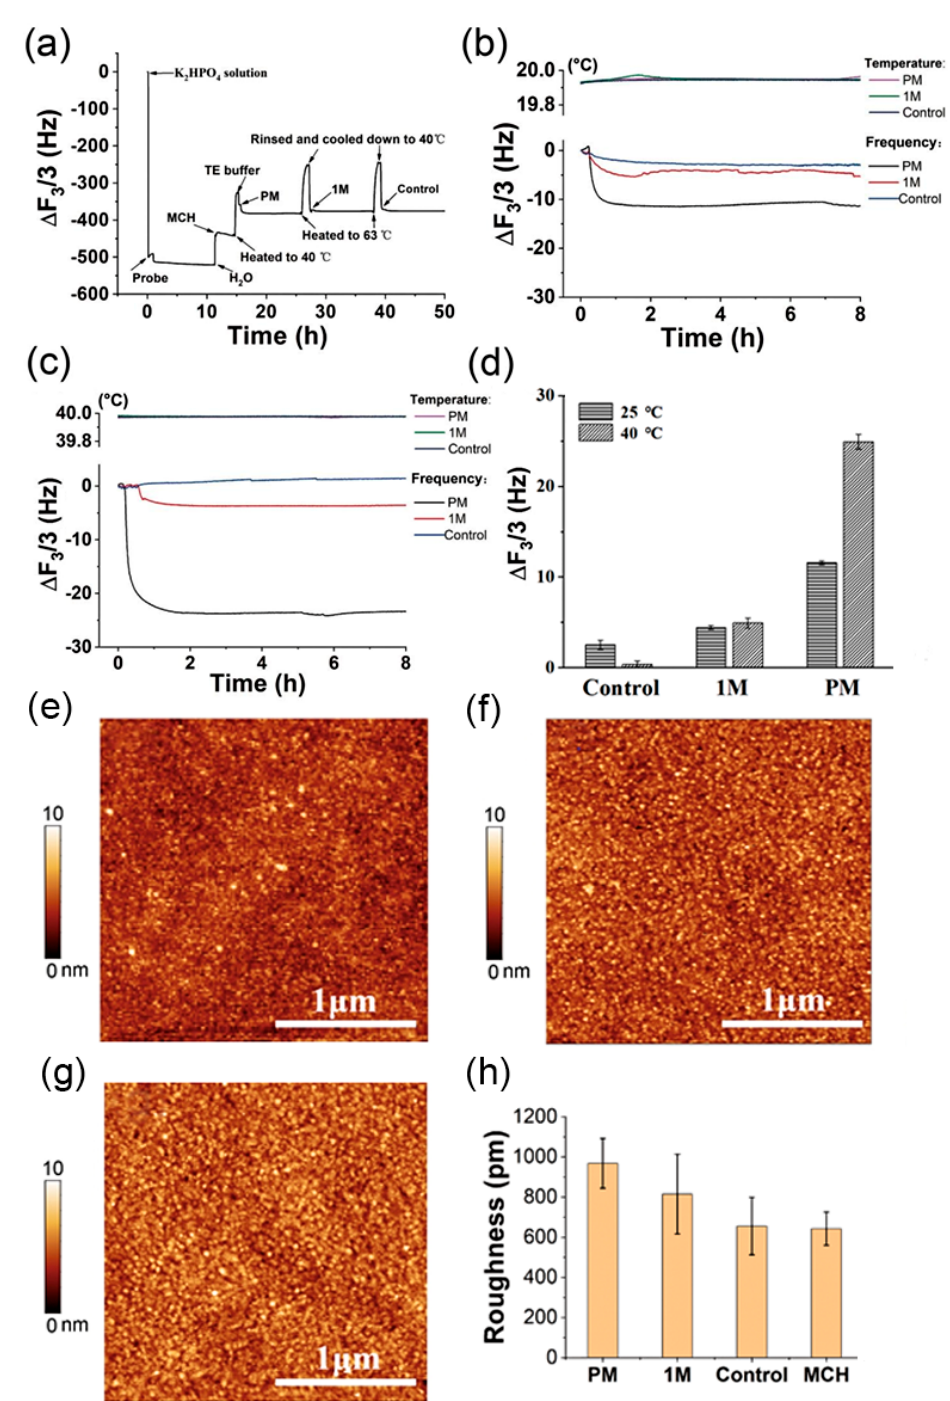
Figure 4. QCM was utilized to measure SNP at different temperatures. ( a ) the frequency of the entire QCM experiment; ( b ) frequency shift for SNP measurement at 20 °C; ( c ) frequency shift for SNP measurement at 40 °C; ( d ) the comparison of QCM frequency shifts at 25 °C and 40 °C; ( e ) AFM image of “Control” sample; ( f ) AFM image of “1 M” sample; ( g ) AFM image of “PM” sample; ( h ) roughness of AFM images of different samples. The scale bar of the AFM image is 1 μ m. The AFM was used to characterize the DNA hybridization of different samples on the gold surface of chips. After incubation with target DNA (including “PM”, “1 M” and “Control”) separately, the QCM chips were rinsed and characterized by AFM. In the AFM